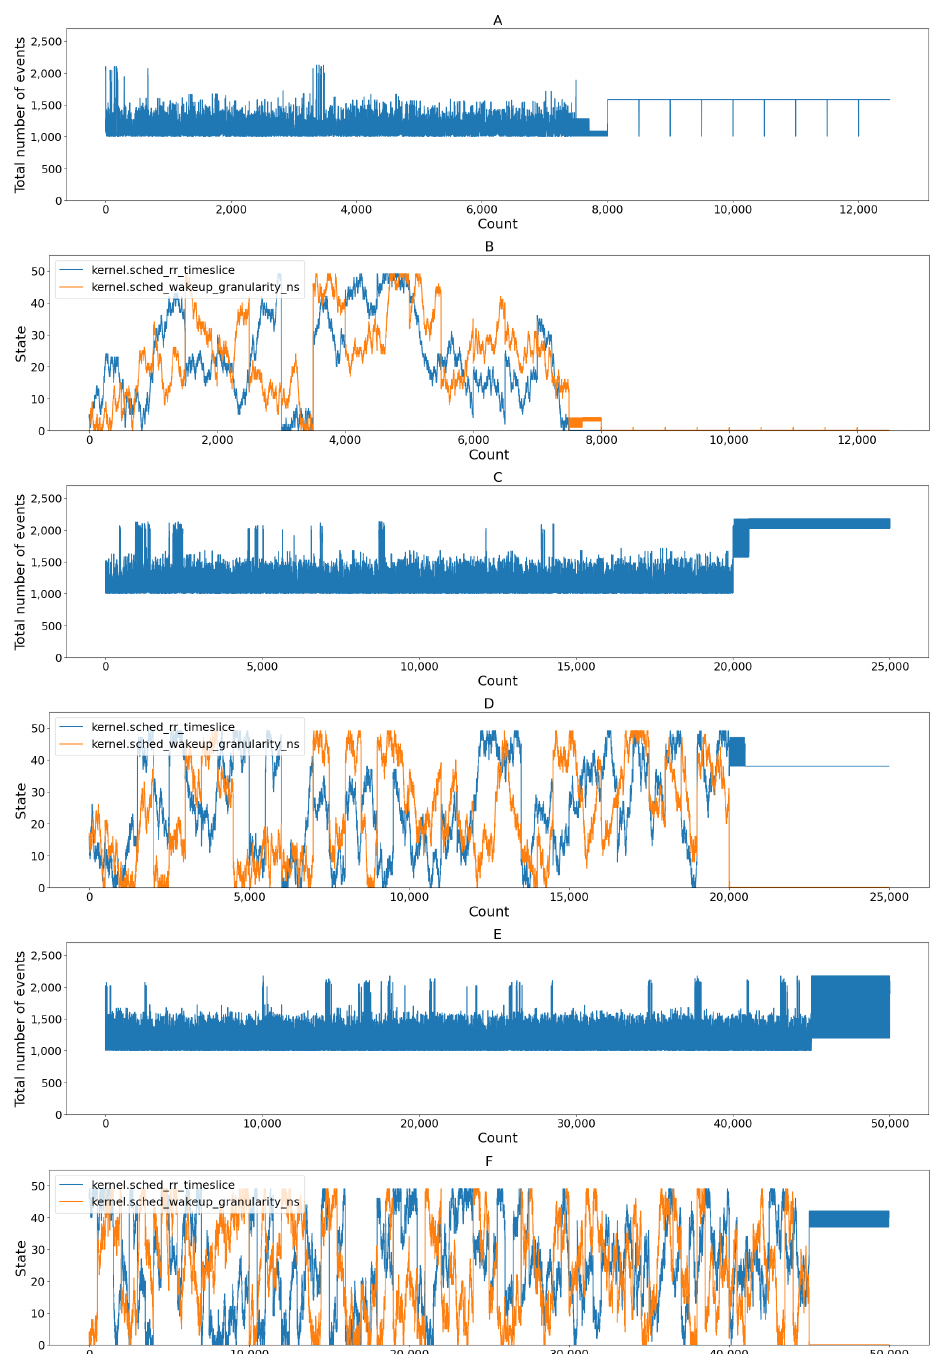
Figure 4. STUN performance according to the number of episodes. The x-axis of each graph is the number of learning iterations. The y-axes of ( A , C , E ) show the performance of Sysbench (the total number of events), and the y-axes of ( B , D , F ) show the state values of each